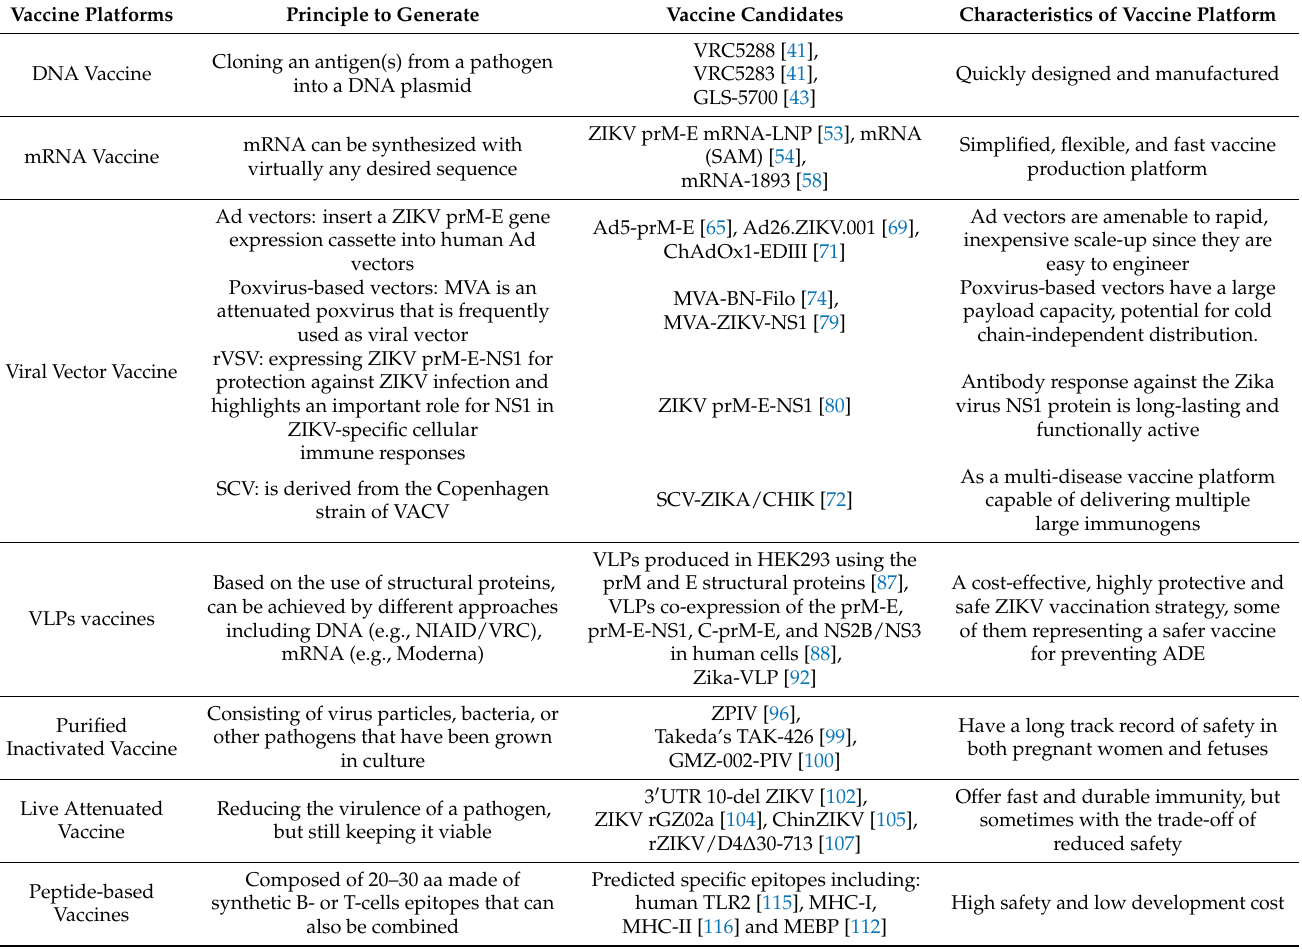
Table 2. Zika vaccine candidates on different vaccine